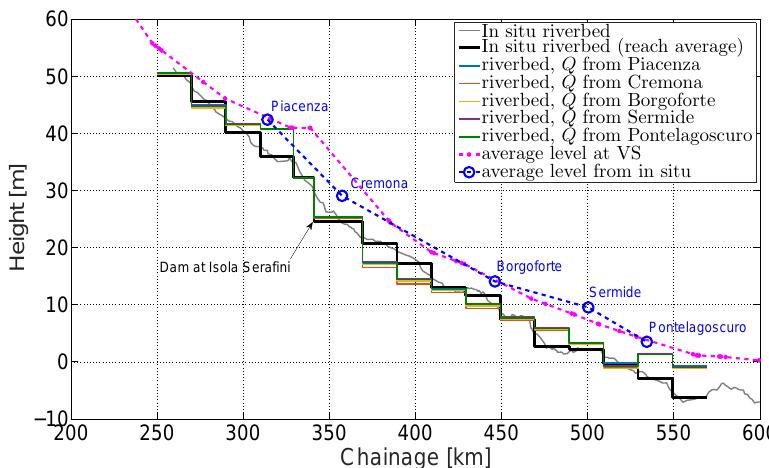
Figure 6. Estimated river bed profile along the Po River for 16 defined reaches. VS refers to virtual station.